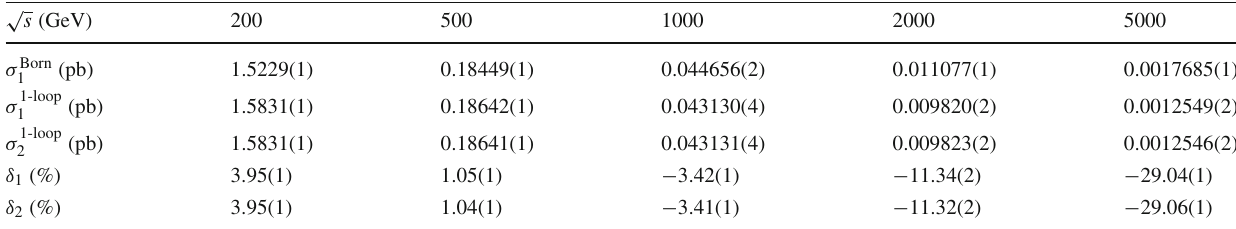
Table 6 Comparison of the Born and one-loop cross sections of the annihilation channel ¯ dd → Z γ(γ) calculated with different values of the soft/hard separation parameter ¯ ω